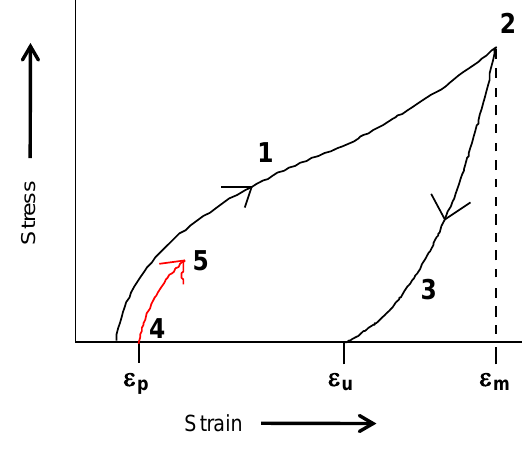
Figure 8. Schematic stress–strain cycle: 1—stretching to ε ε = 300% elongation; 3—stress is removed and sample contracts to ε m recovers and reaches ε after heating; 5—start of the next p